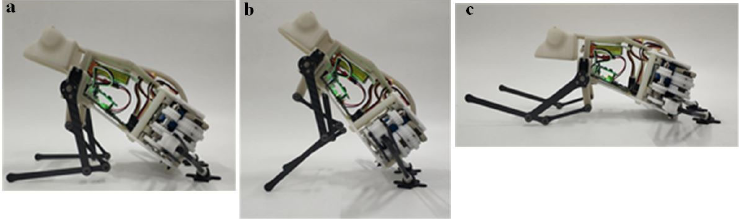
14 of 18 Figure 12. The overall structure model of the robot and the actual prototype. 3.2. Experiments and Results The host computer program is developed using C# to control the frog jumping robot. The user interface is mainly divided into a serial port setting module, a demonstration module, and a debugging module. The lower computer program is written in the KEIL MDK 5 development environment to control and use each motor and sensor module, col ‐ lect data, and process data. Each action of the robot is indicated and controlled by the corresponding FLAG action flag variable, and the corresponding Bluetooth serial commu ‐ nication protocol is configured. In this way, various test experiments are carried out on the actual motion effect of the robot.